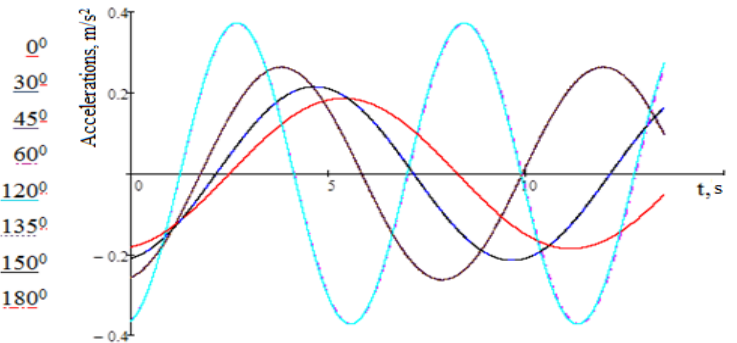
Figure 21. Accelerations that act on the hopper wagon.